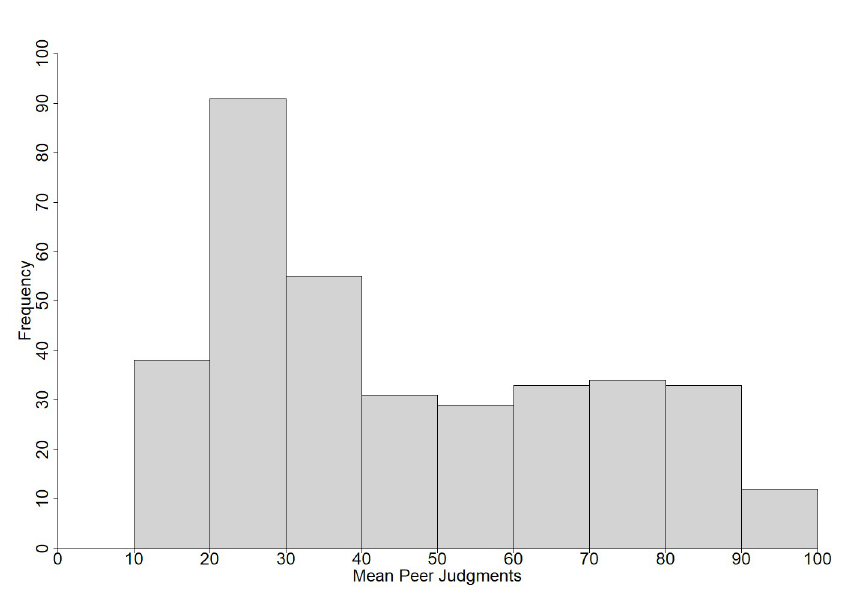
Fig 3. Histogram of the mean peer judgments for all